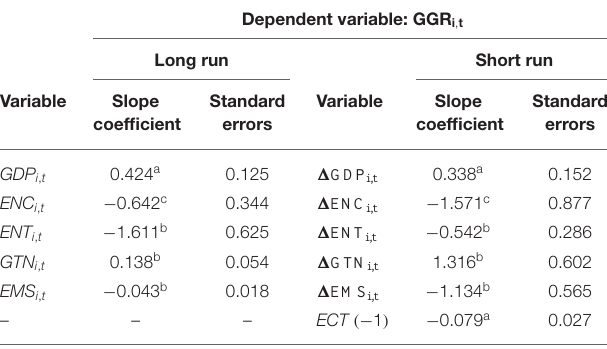
TABLE 7 | CS–ARDL